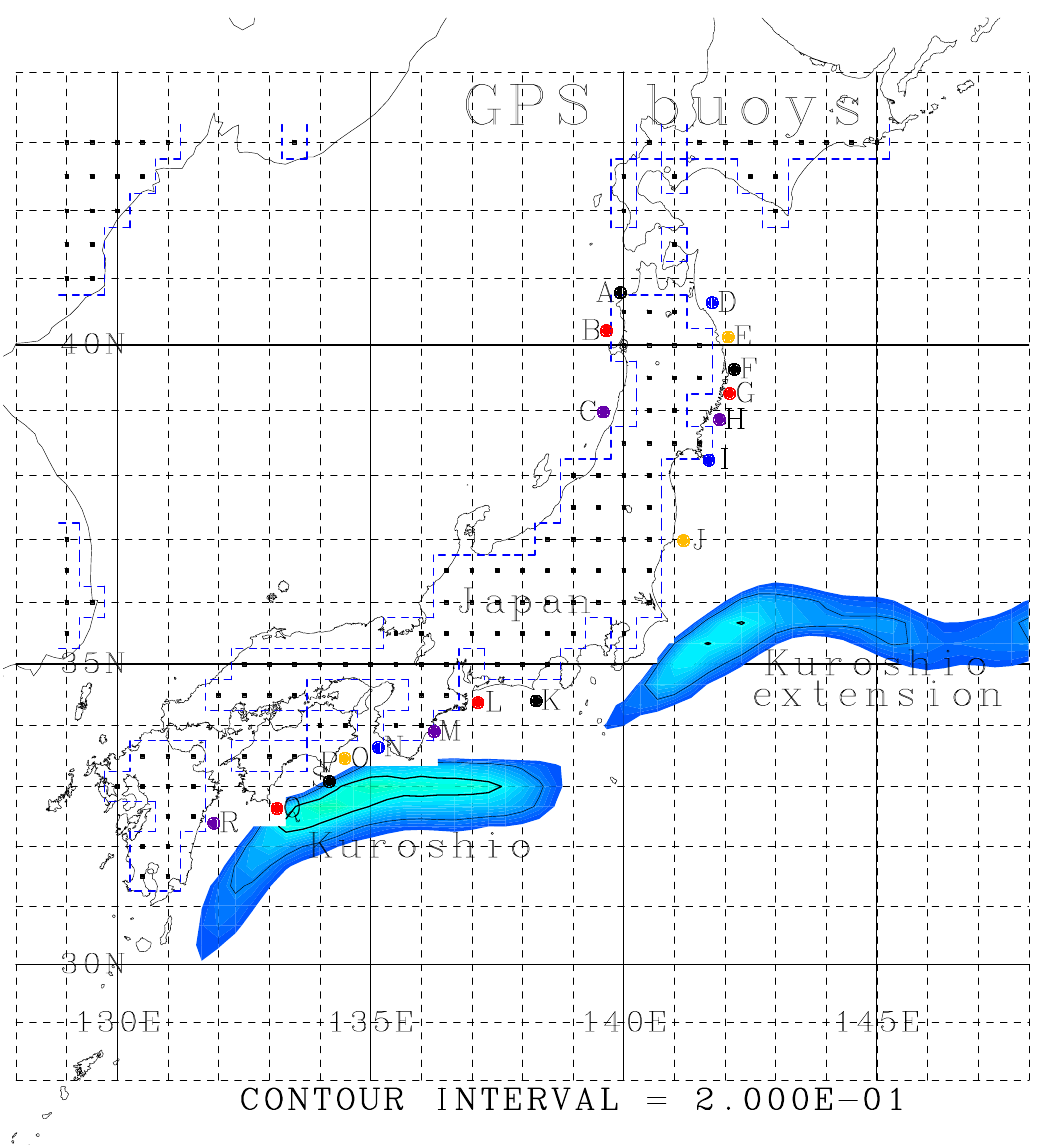
> 0.6 ms − 1 (from 2001 to 2017). Black squares: U r |(cid:104) (cid:105)|